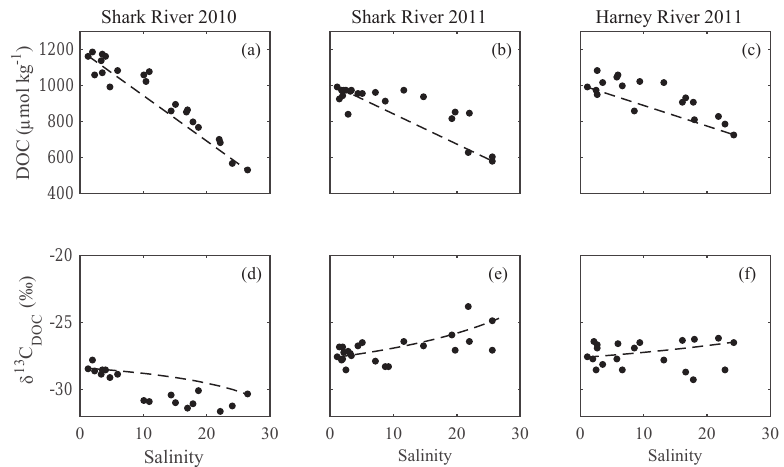
Figure 4. Distribution of DOC and δ 13 C DOC along the salinity gradient in the Shark and Harney rivers in samples collected during Shark- TREx 1 and 2. The dashed lines indicate the distribution expected for conservative